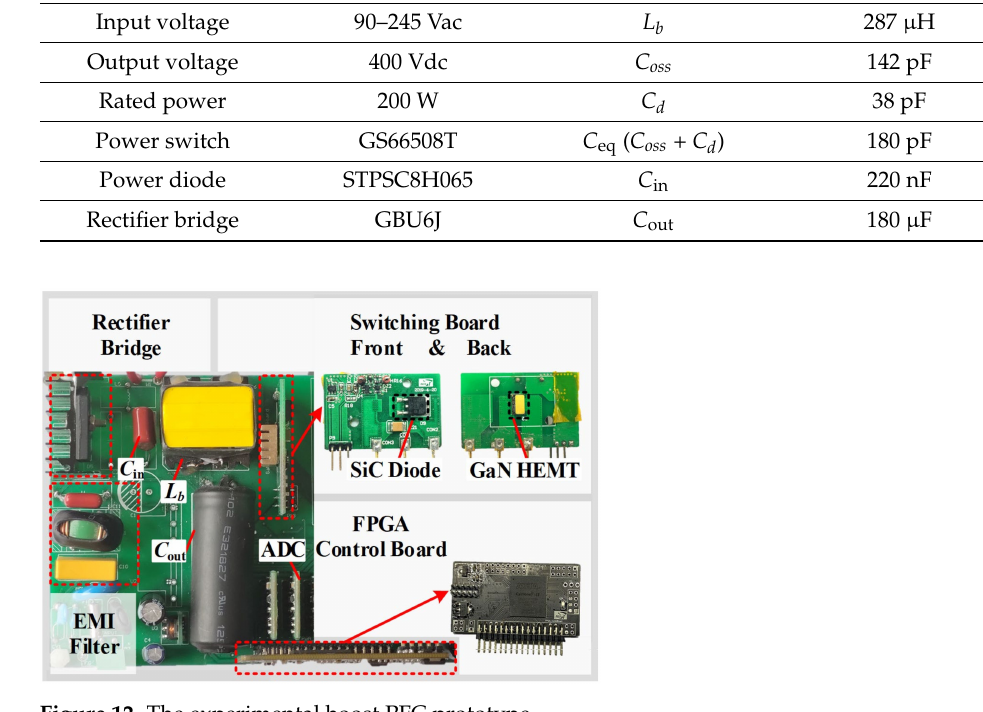
Figure 12. The experimental boost PFC